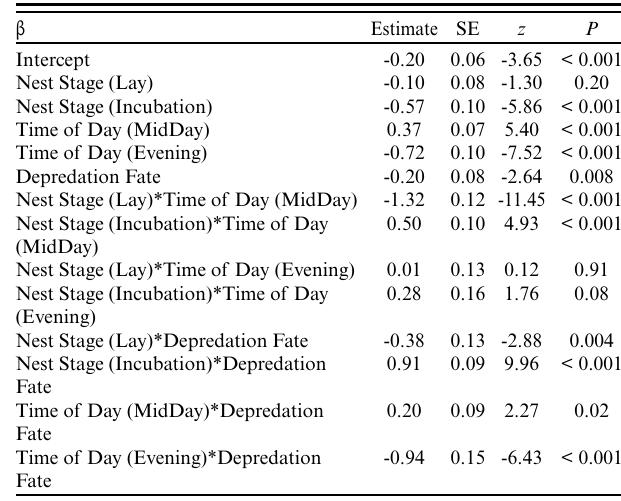
Fig. 2 . Predator-attraction hypothesis: depredation fate. Interaction means from the best model of “near-nest” vocalizations by male vireos in central Texas, 2013– 2014, considering depredation fate, (A) time of day and (B) nest stage. Vocalizations at nests that were eventually depredated are indicated in black; vocalizations at nondepredated nests are in gray. Standard errors are all too small to display accurately (all SE are <0.12).